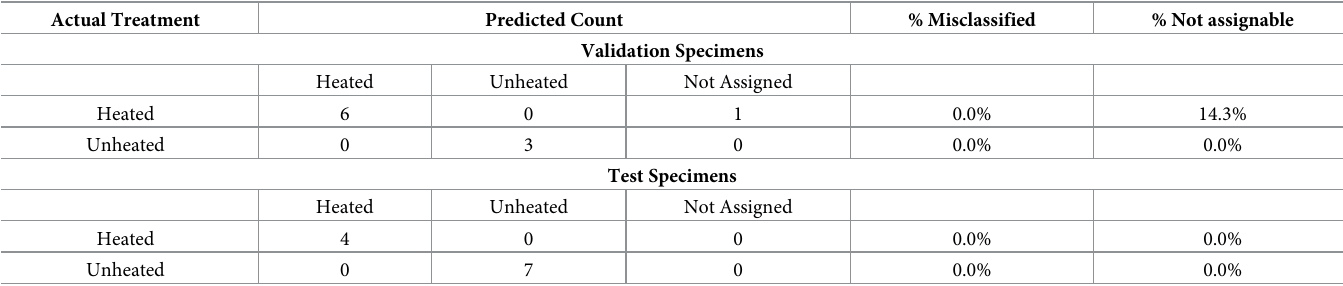
Table 13. k-NN model D specimen-level prediction results.